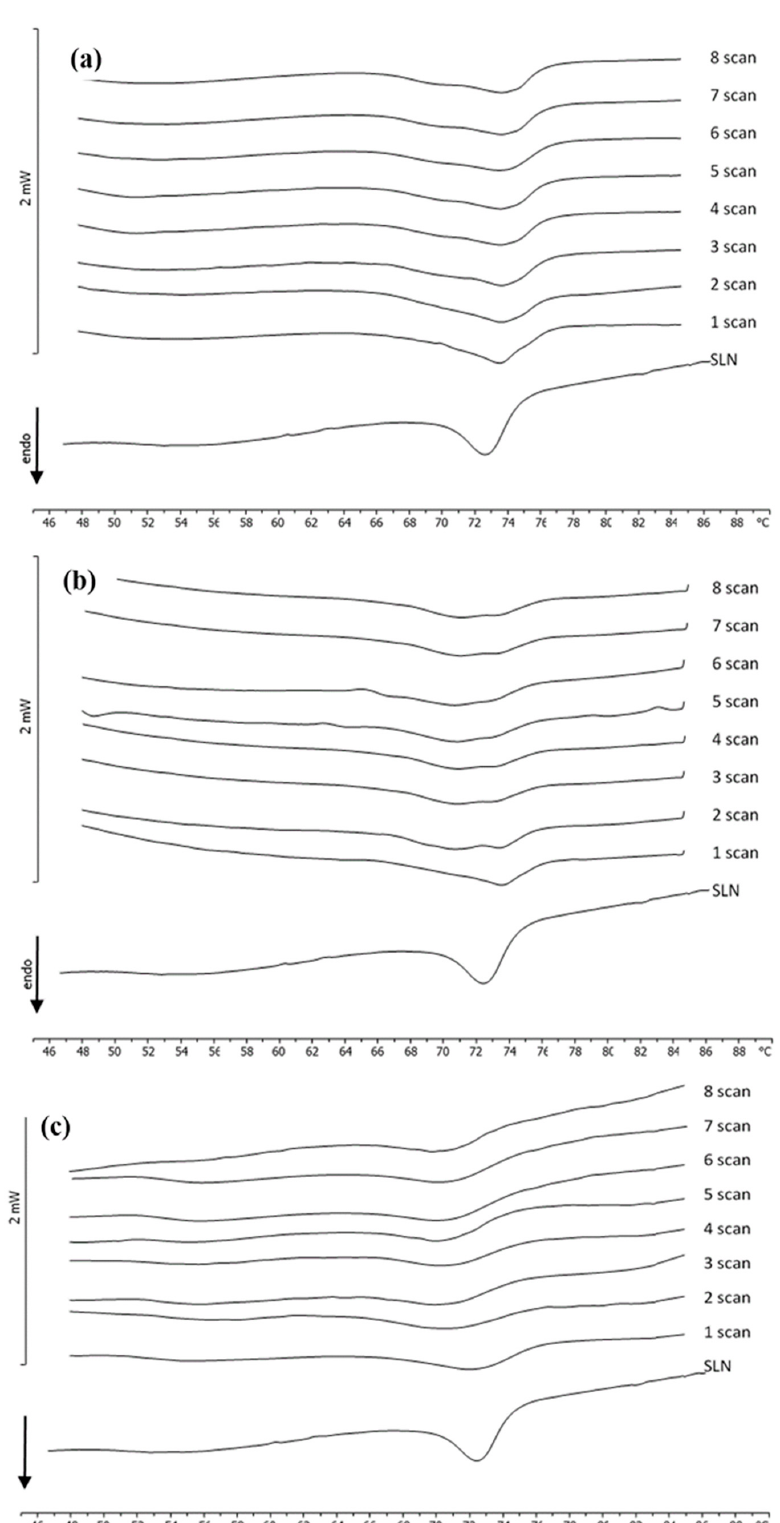
Figure 9. Calorimetric curves, in heating mode, of SLNs left in contact with PEG micelles ( a ) 1:0.1, ( b ) 1:0.5, and ( c) 1:1 at increasing time of incubation.